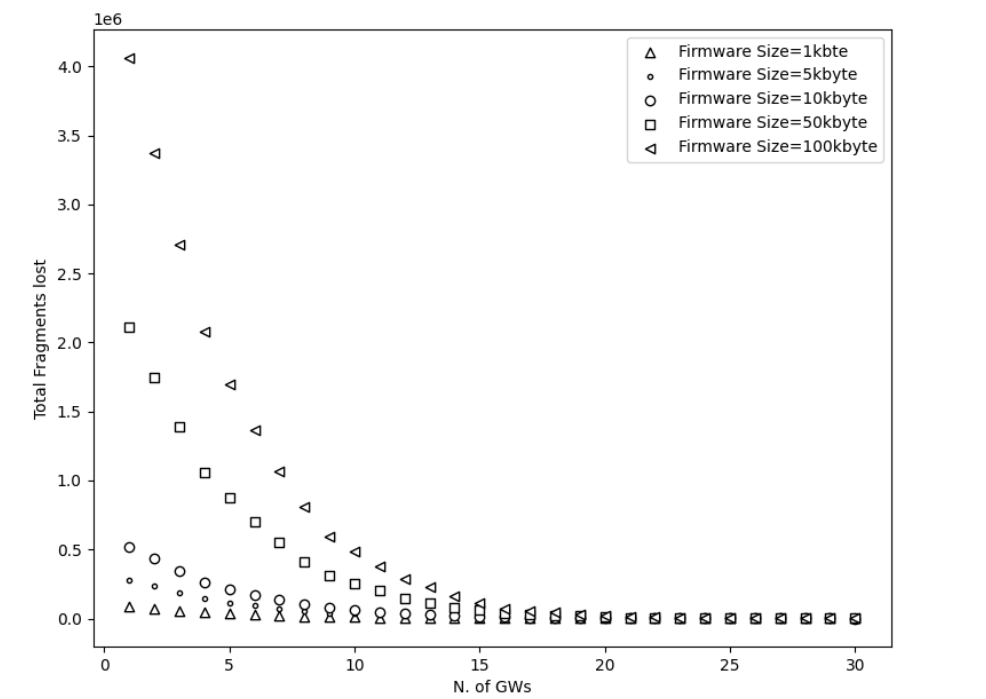
Figure 5. Fragments lost using different firmware